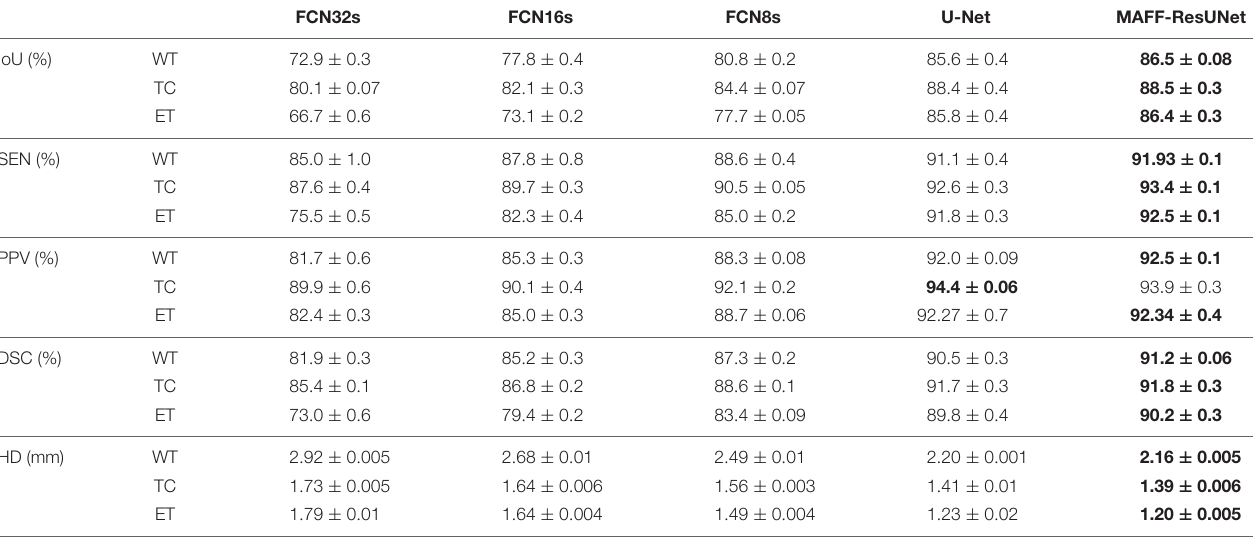
Bold indicates the maximum value of IoU, SEN, PPV, DSC, and the minimum value of HD among these methods. (cid:12) (cid:12) respectively; (cid:12) represents the intersection between p k (cid:12) p k ∩ g k (cid:12) (cid:12) (cid:12) (cid:12) and g k ; (cid:12) and (cid:12) g k (cid:12) are the number of pixels in p k and g k (cid:12) p k